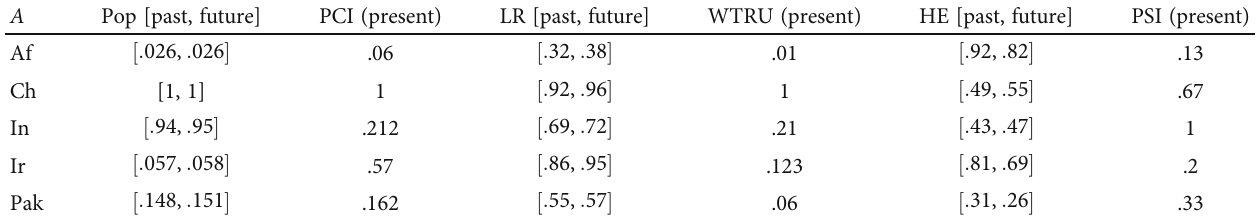
Table 8: A neutrosophic cubic representation for vertex set A